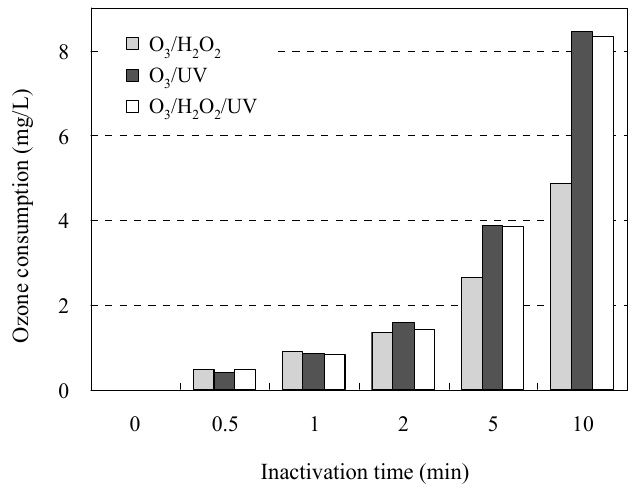
Figure 4. O 3 consumption over time in STP wastewater in each treatment system.